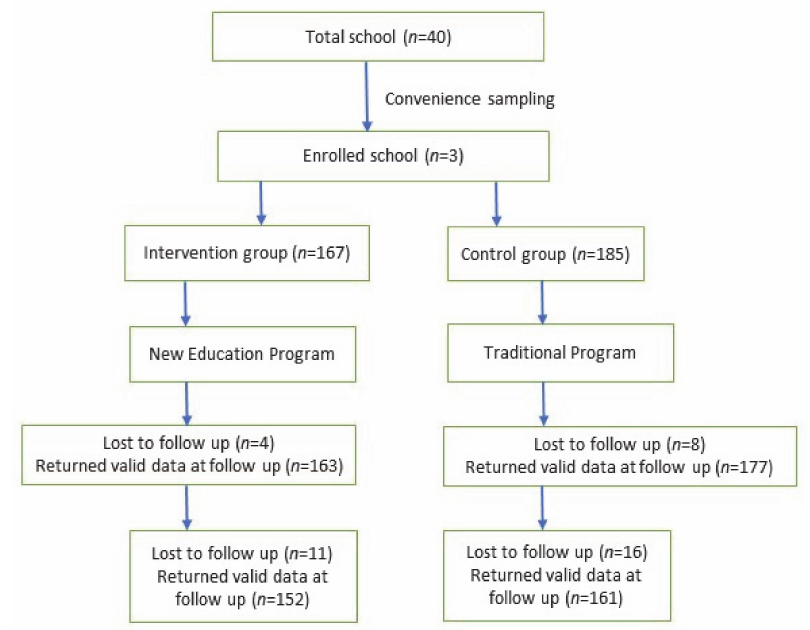
Figure 1. Flowchart of the